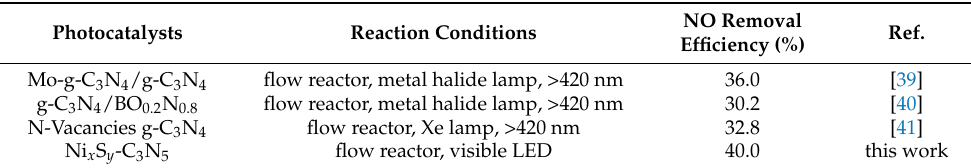
Figure 8. ( a ) Comparison of photocatalytic NO removal behaviors on Ni x S y , C 3 N 5 and Ni x S y -C 3 N 5 . Durability ( b ) and cyclability ( c ) of photocatalytic NO removal on 1.0 wt% Ni x S y -C 3 N 5 . Detection of NO 2 ( d ) and NO 3 − ( e ) during photocatalytic NO removal on Ni x S y -C 3 N 5 . Table 2. The comparison of the photocatalytic NO removal performance of the Ni x S y -C 3 N 5 with some reported